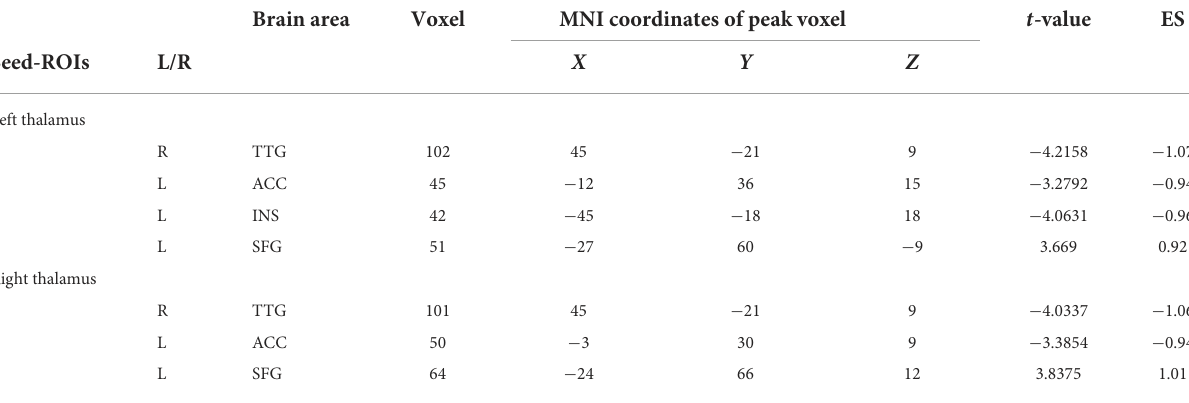
TABLE 2 Brain areas showing functional connectivity differences with the thalamus between PACG patients and HCs. Brain area